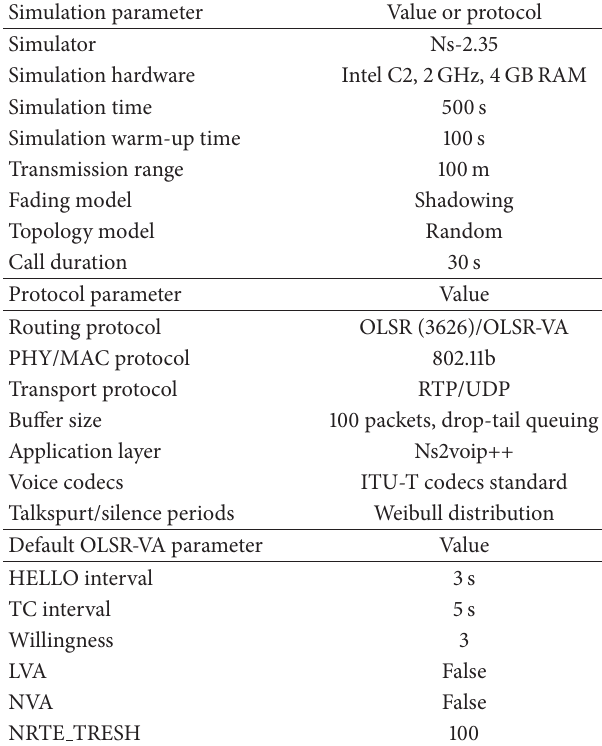
Table 2: Simulation and protocol